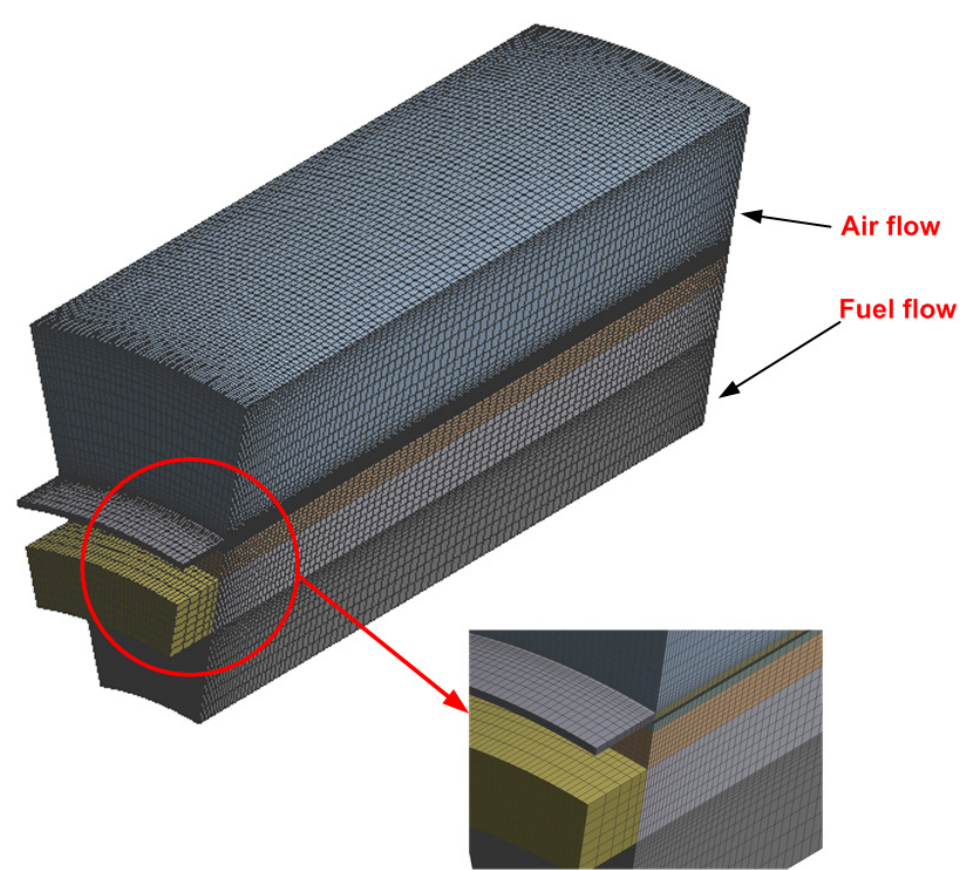
Figure 4. The computational domain used in the analysis (not to scale).